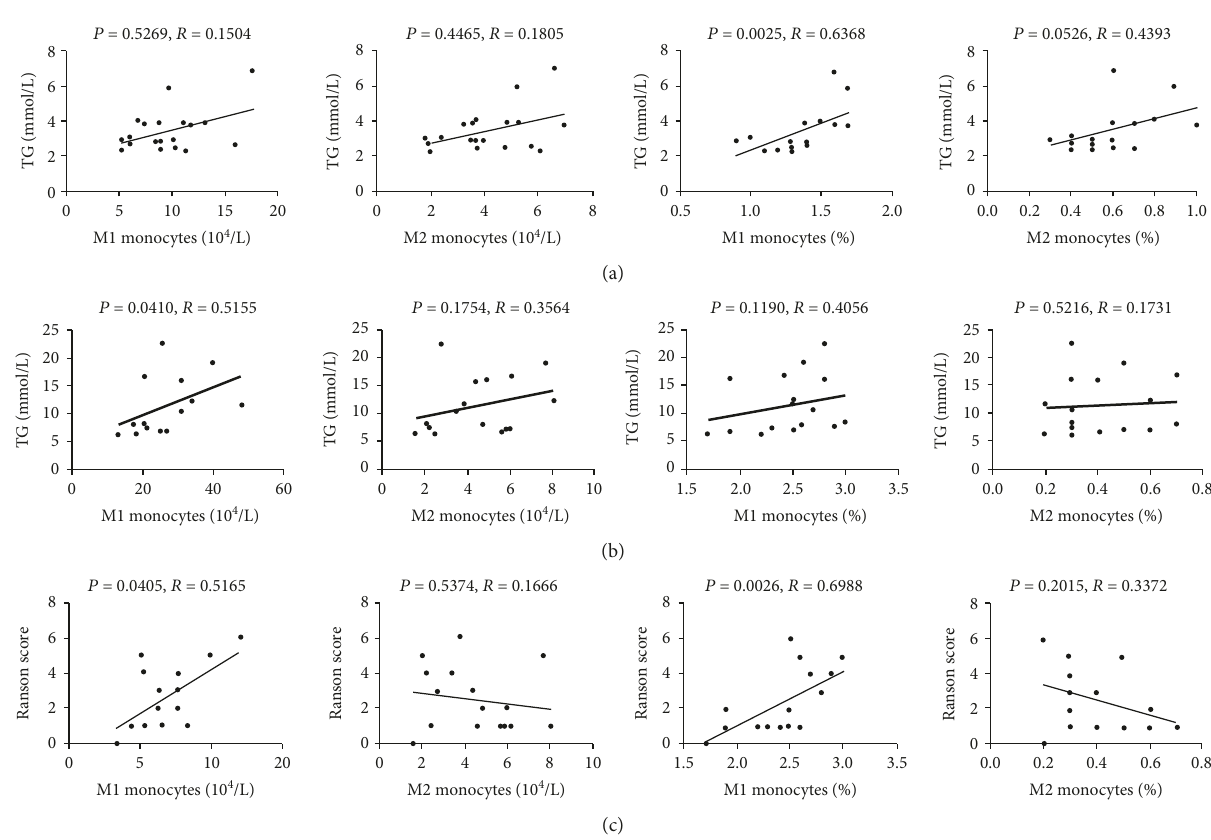
Figure 4: Correlation analysis of monocyte subsets with clinical parameters by spearman test. Association between plasma level of TG and M1 and M2 monocyte count and percentage in the (a) HTG group and (b) HTGP group. (c) Association between Ranson score and M1 and M2 monocyte count and percentage in the HTGP